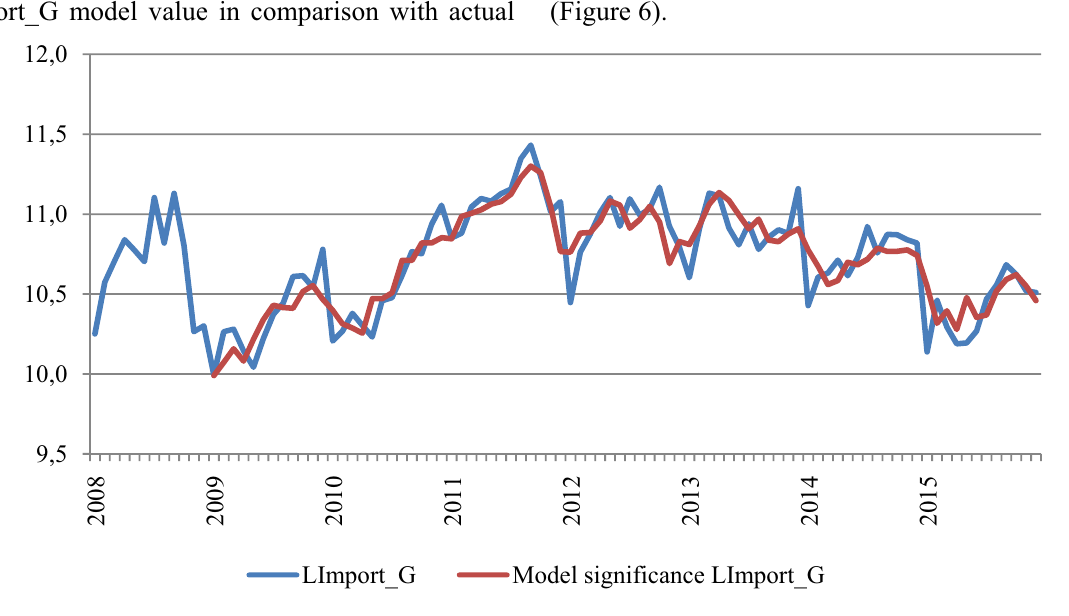
Fig. 6. Actual and calculated values according to the VAR model for goods import in Sumy